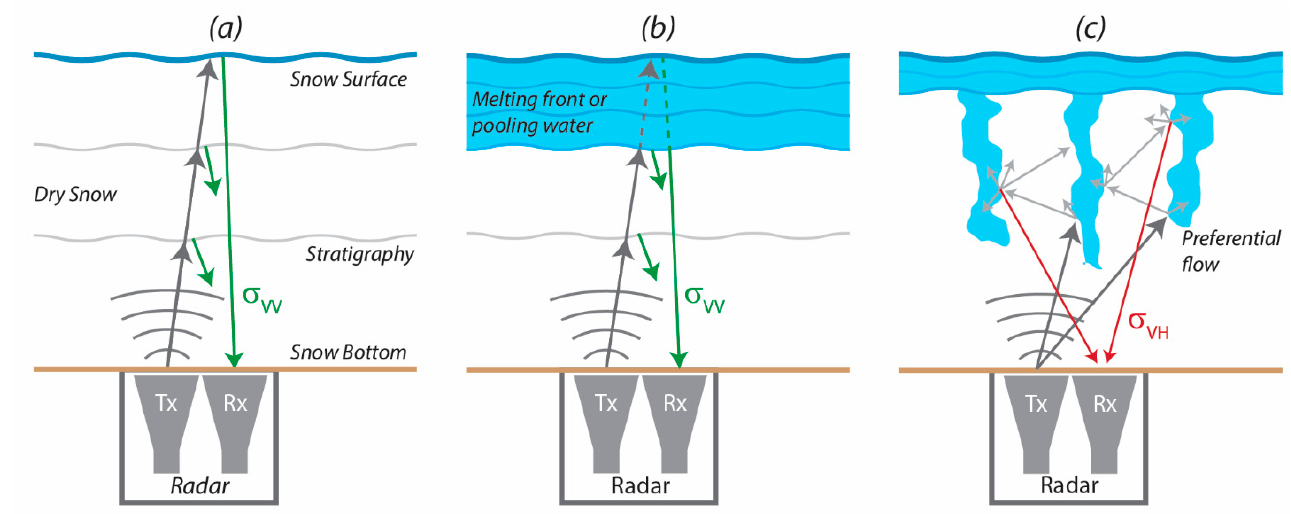
Figure 1. Idealized schematic of an upward-looking radar configuration in ( a ) dry snow, ( b ) melting snow with wetting front, or ( c ) pooling water preferential flow paths. Single scattering returns are co-polarized ( σ VV , shown in green), while multiple scattering returns are depolarized and detected with the cross-polarized antenna ( σ VH , shown in red).